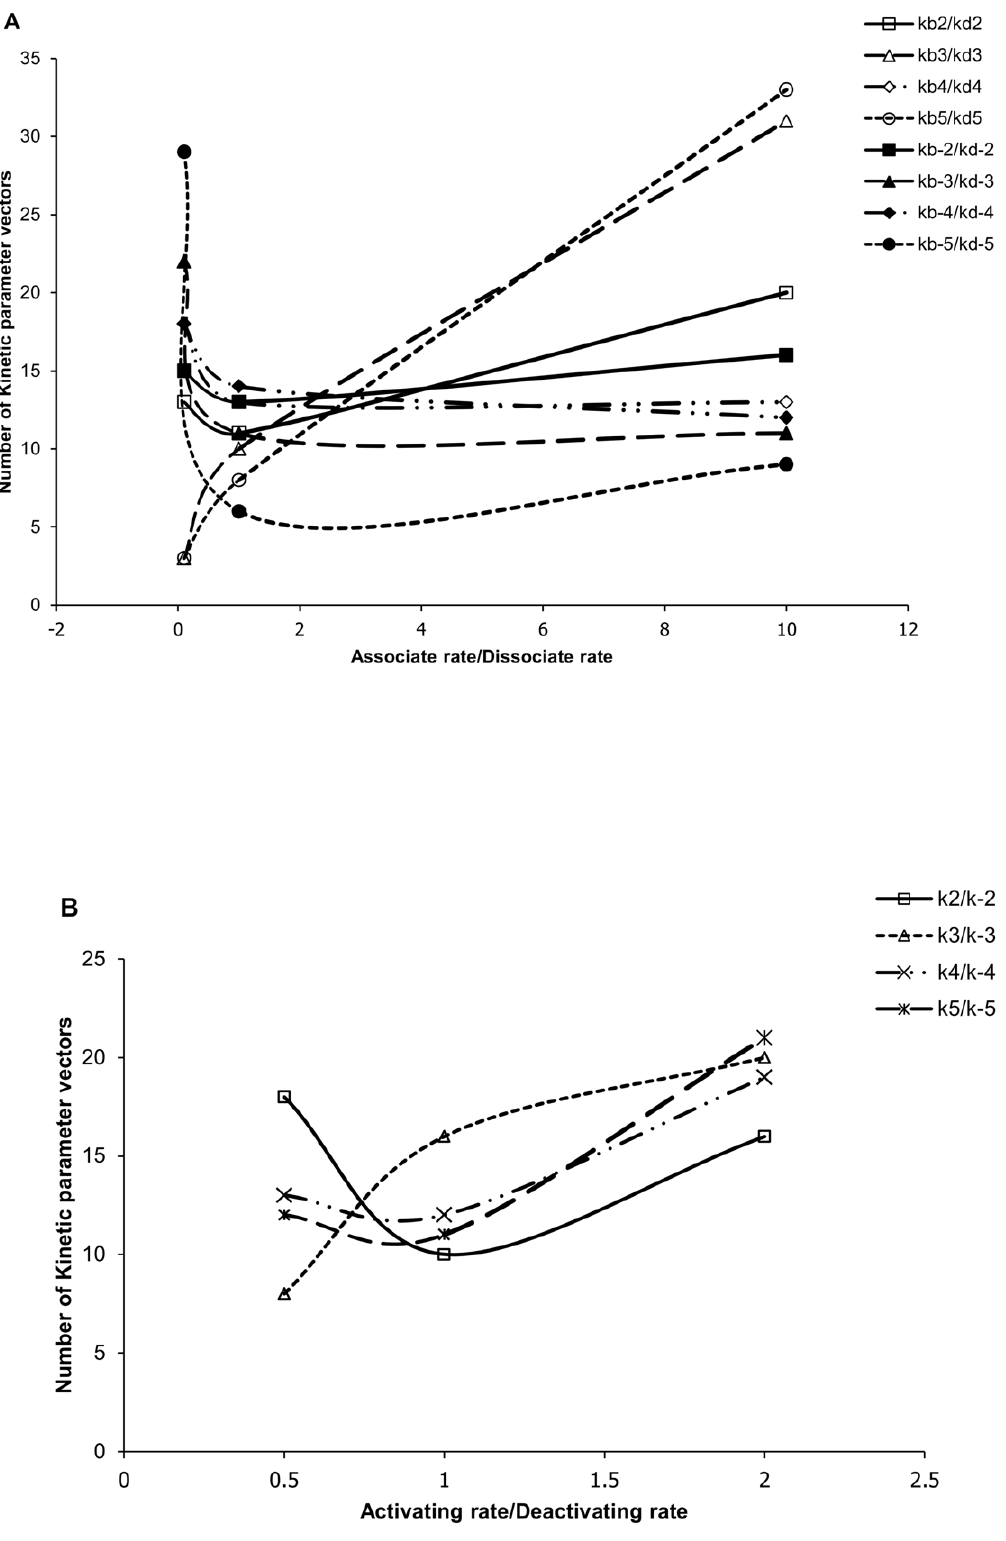
Figure 4. Number of kinetic parameter vectors (vertical axis) that lead to large Gradient ( Gradient . 400) for MAPK activation (see text). As in Figure 3, the numbers are shown for different ratios (horizontal axis) of (a) various association rates (kbN and kb-N) over the respective dissociation rates (kdN and kd-N), and (b) various activation rates (kN) over the respective deactivation rate (k-N).